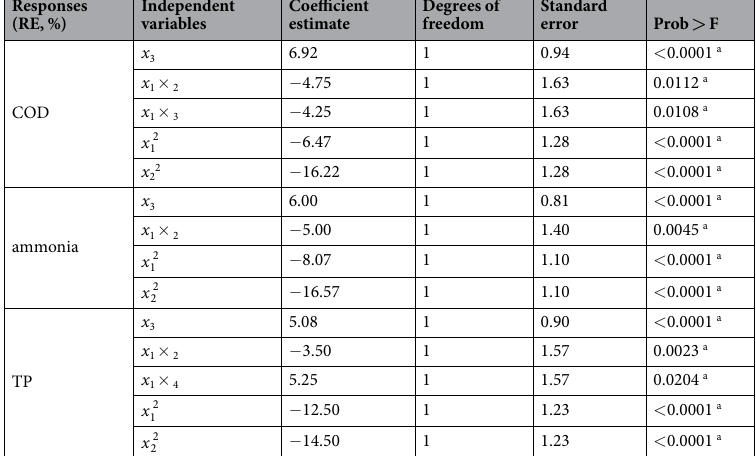
Table 3. Significance of quadratic model coefficient of for the three responses. a Significant.